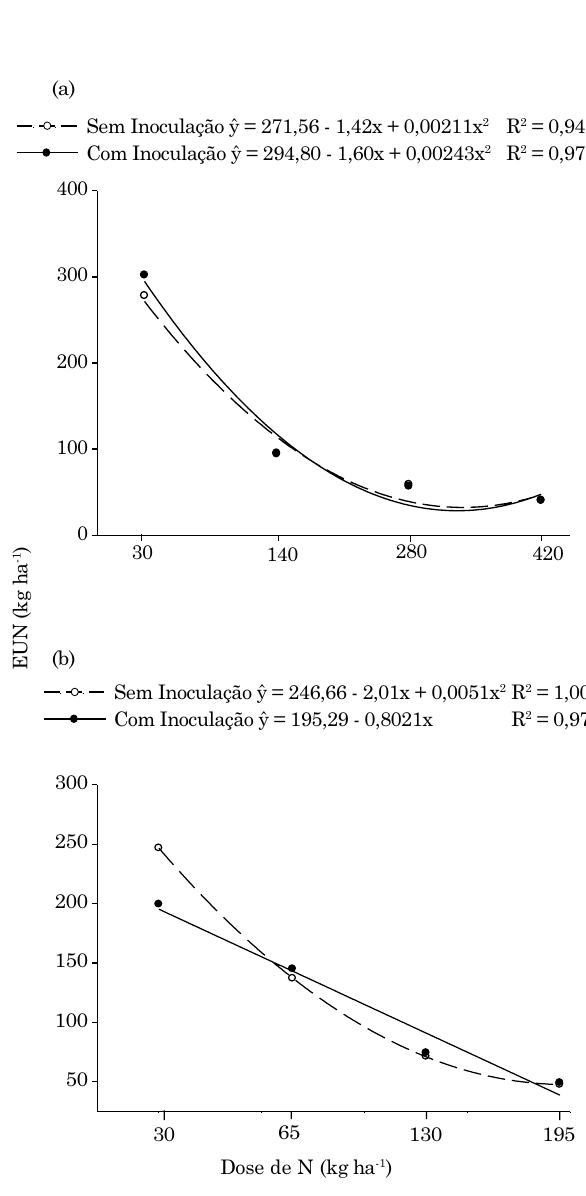
Figura 4. Eficiência agronômica de uso do nitrogênio (eUn) do milho em função de doses de nitrogênio, com e sem inoculação das sementes com Azospirillum , nos níveis de manejo alto (a) (parte superior) e médio (b) (parte inferior), em lages, sc, durante os anos agrícolas